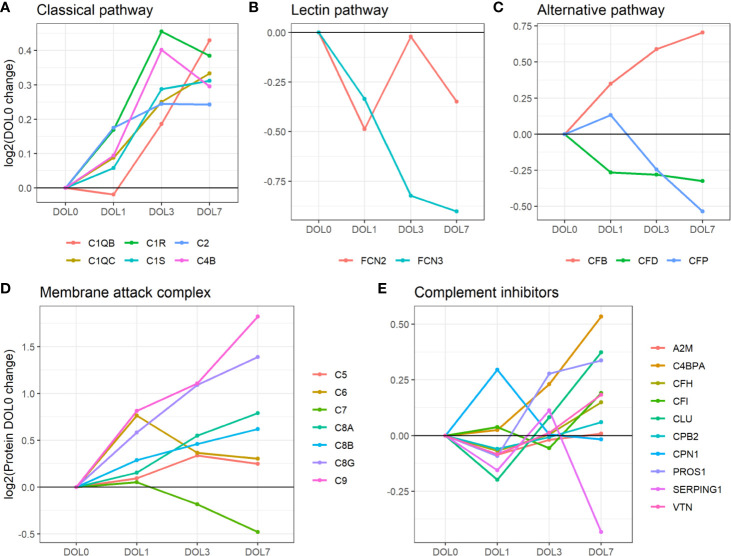
Average change of complement proteins grouped by their function across the first week of life compared to DOL0. (A) classical pathway, (B) lectin pathway, and (C) alternative pathway. (D) Membrane attack complex (MAC) proteins, (E) complement inhibitors. Pathway activations from Gene Ontology without further curation.